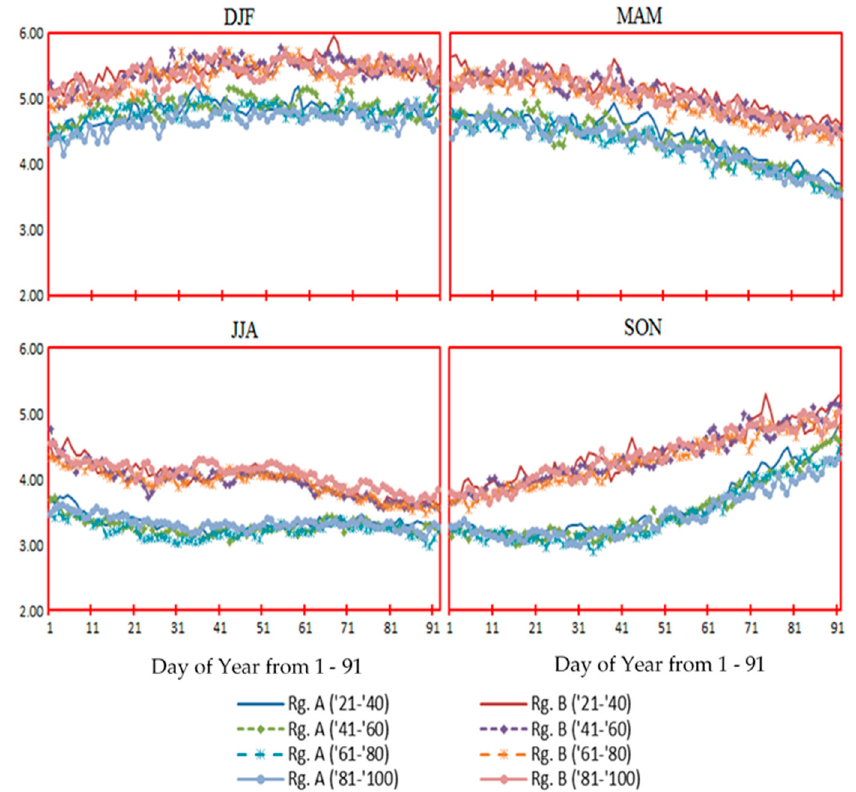
Figure 6. Seasonal mean wind speed for regions A and B from 2021–2040, 2041–2060, 2061–2080, and 2081–2100 in winter (DJF), spring (MAM), summer (JJA) and autumn (SON) from top right to bottom left respectively under RCP8.5 scenario.